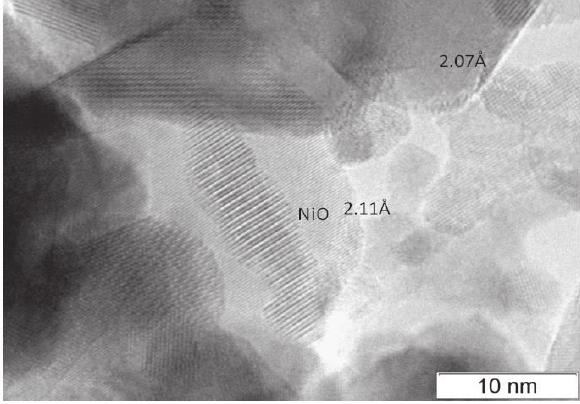
Figure 10a: UV-Vis spectra of Ni-loaded Ce-Zr-O oxides. 1– 5Ni/